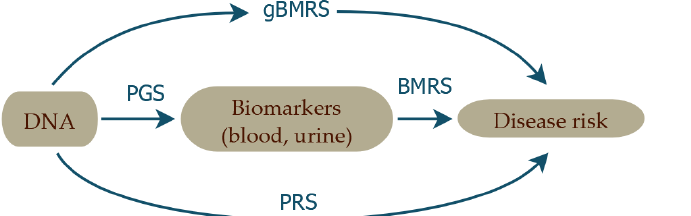
Figure 1. The four different types of predictors appearing in this